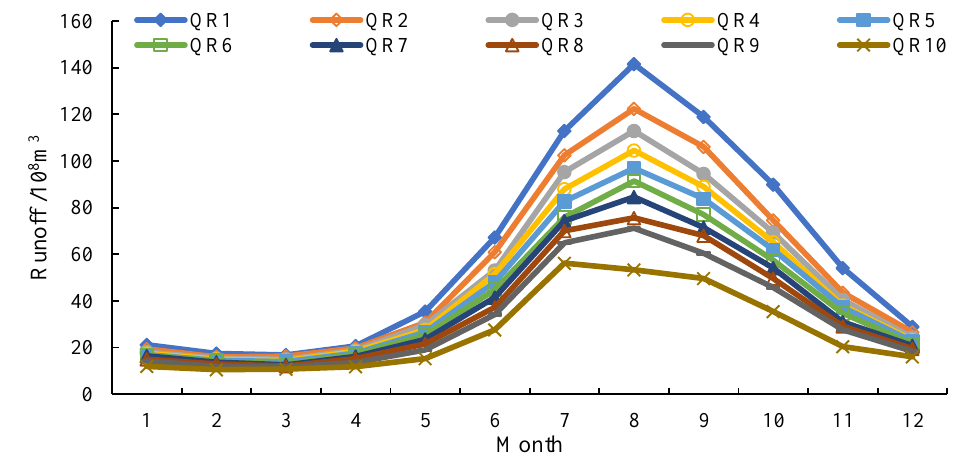
The monthly runoff of the NZD hydropower plant was sorted in descending order, 10 representative runoff QR ( QR 1 representing the average of the runoff in P ∈ ( 0, 10% ] , QR 2 representing for the average of runoff in P ∈ ( 10%, 20% ] , etc.) were selected, and the runoff in each month under the same QR was plotted on the same curve (Figure 8).